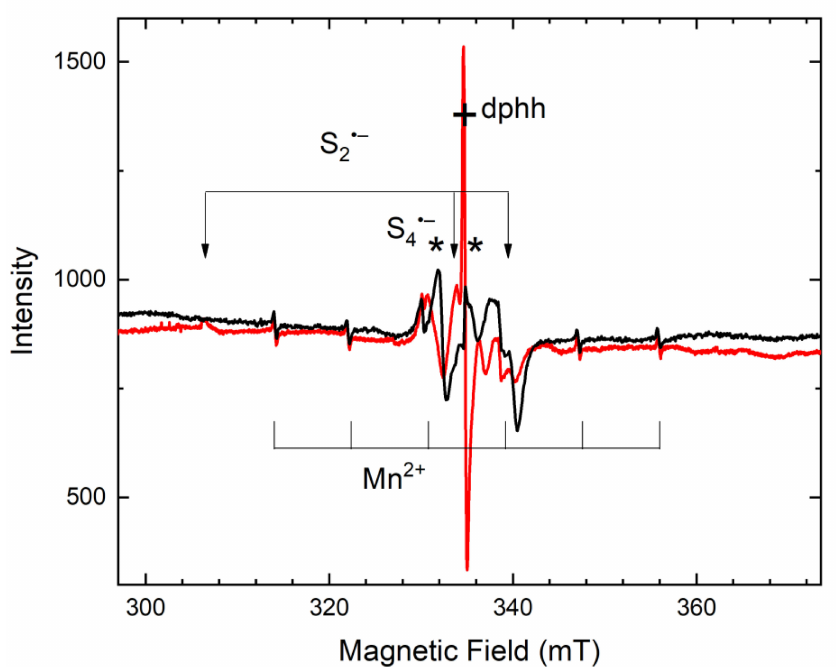
Figure 17. ESR spectra of purple tugtupite (Sample 8 irradiated by UV light, black curve) and almost colorless tugtupite (initially purple sample irradiated by light with the wavelength of 532 nm, red